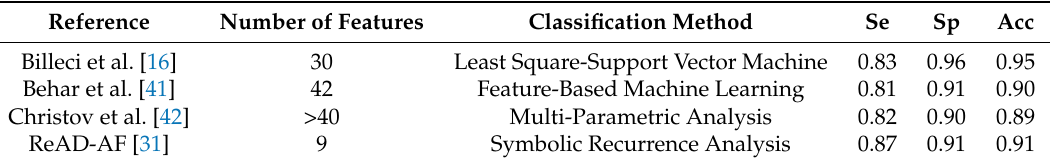
Table 2. Comparison of the sensitivity, specificity, and accuracy between some Physionet Challenge 2017 methods and our